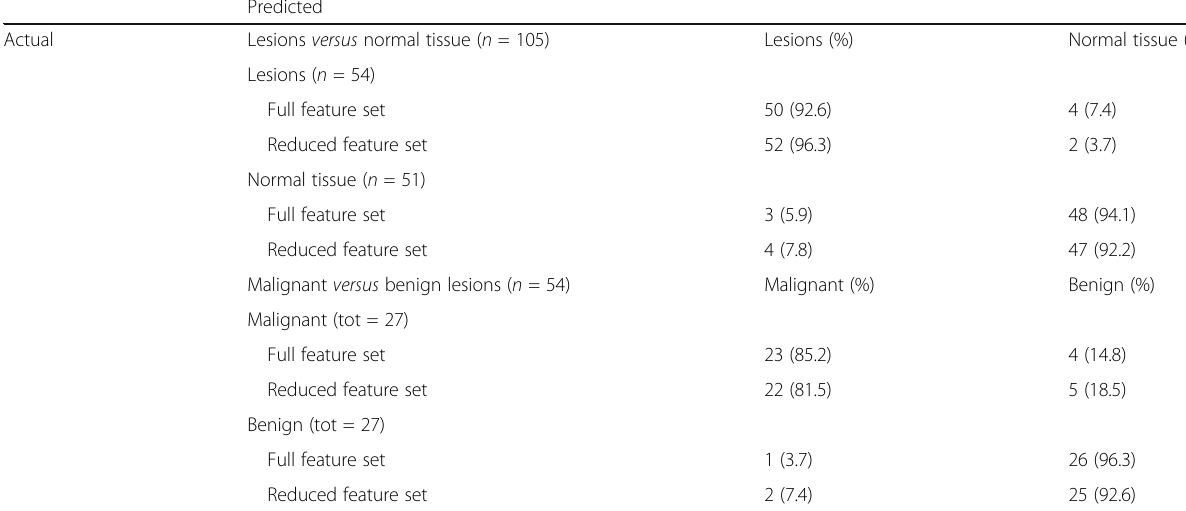
Table 5 Results in the validation set for the classification of lesions versus normal tissue and malignant versus benign solid lesions using the full texture feature and the reduced feature set